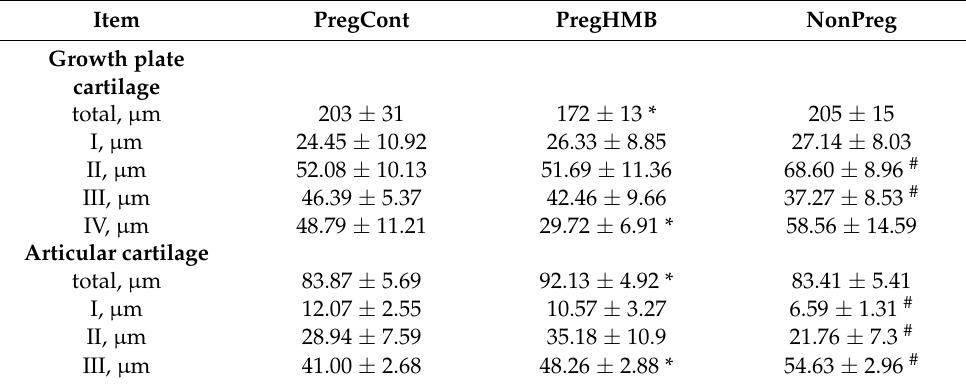
Table 4. The thickness of the epiphyseal and articular cartilage zones of femora from pregnant (control and supplemented with β -Hydroxy β -methylbutyrate (HMB)) and non-pregnant female spiny